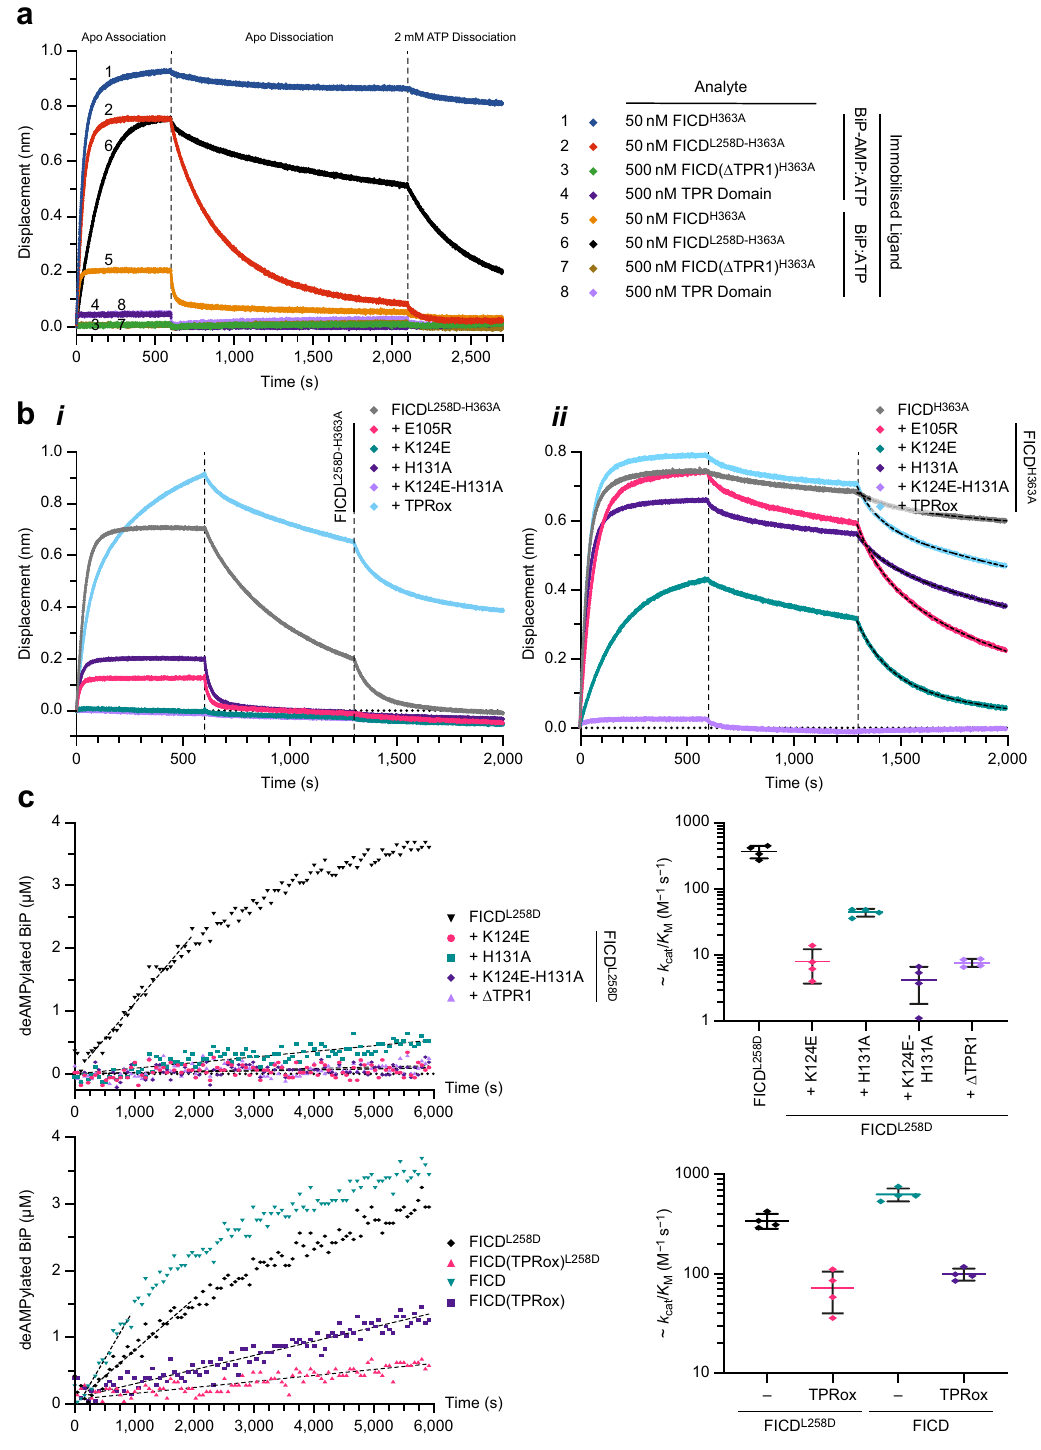
Fig. 3 FICD ’ s TPR domain is essential for BiP-AMP binding and deAMPylation. a Representative BLI association – dissociation curves of FICD analytes from immobilised BiP (either AMPylated or unmodi fi ed) bound to ATP ( n = 3 independent experiments). See Supplementary Fig. 4d. b Representative BLI analysis of TPR domain mutants of monomeric ( i ) and dimeric ( ii ) FICD binding to immobilised AMPylated BiP ( n = 3 independent experiments). In both a and b the buffer used in the second dissociation step (see vertical dashed lines) was supplemented with 2mM ATP. In b ( ii ) the second dissociation step traces (where applicable) are overlayed with the best- fi t curves derived from a two-phase exponential decay model. See Supplementary Fig. 4e, f. c Analysis of the ability of different FICD variants to deAMPylate BiP. Left, Fluorescent polarisation-derived time courses of BiP-AMP(FAM) deAMPylation. Fits of the initial linear reaction phase are overlaid. Right, quanti fi cation of the approximate catalytic ef fi ciencies of the different FICD variants. Mean values of approximate k K n = 4 independent experiments, are shown. See Supplementary Fig. 5. For reasons of cat / M values for each FICD variant ± standard deviation (SD), from experimental expedience, the Glu105Arg FICD mutant was not incorporated into an enzymatically competent FICD background and was, therefore, neither tested in this in vitro deAMPylation assay nor in the vitro AMPylation assays shown later (Fig. 5a). Source data are provided as a Source Data fi